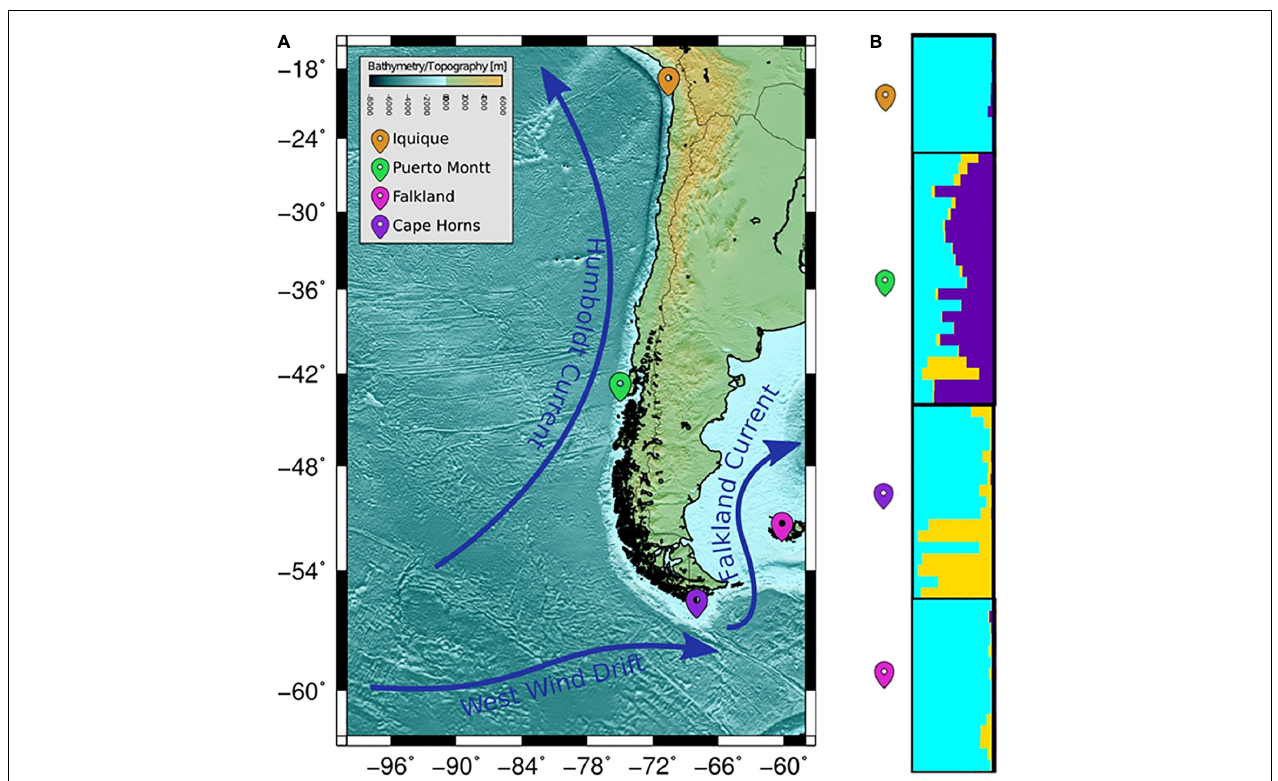
FIGURE 5 | Population samples of sites across the Pacific and Atlantic Ocean. (A) Wide panorama of distance between both pacific and Atlantic Ocean populations utilized for sample collecting. (B) Plots of membership coefficients ( q ) for K = 2 clusters generated using the correlated allele frequency models in STRUCTURE for Patagonian toothfish genotypes in the four different